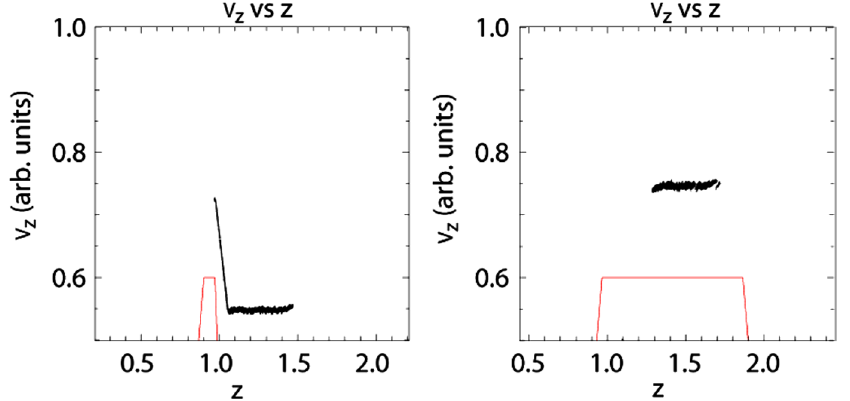
FIG. 3. (Color) The phase space of the ion beam is lifted horizontally after the voltage swept through it. The helix starts at z ¼ 0 : 7 m and ends at z ¼ 1 : 9 m